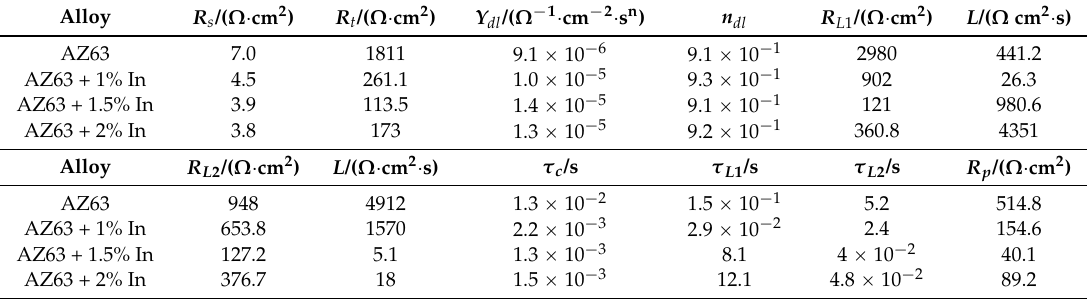
Table 3. Electrochemical parameters of AZ63 and AZ63I alloys obtained by fitting the electrochemical impedance